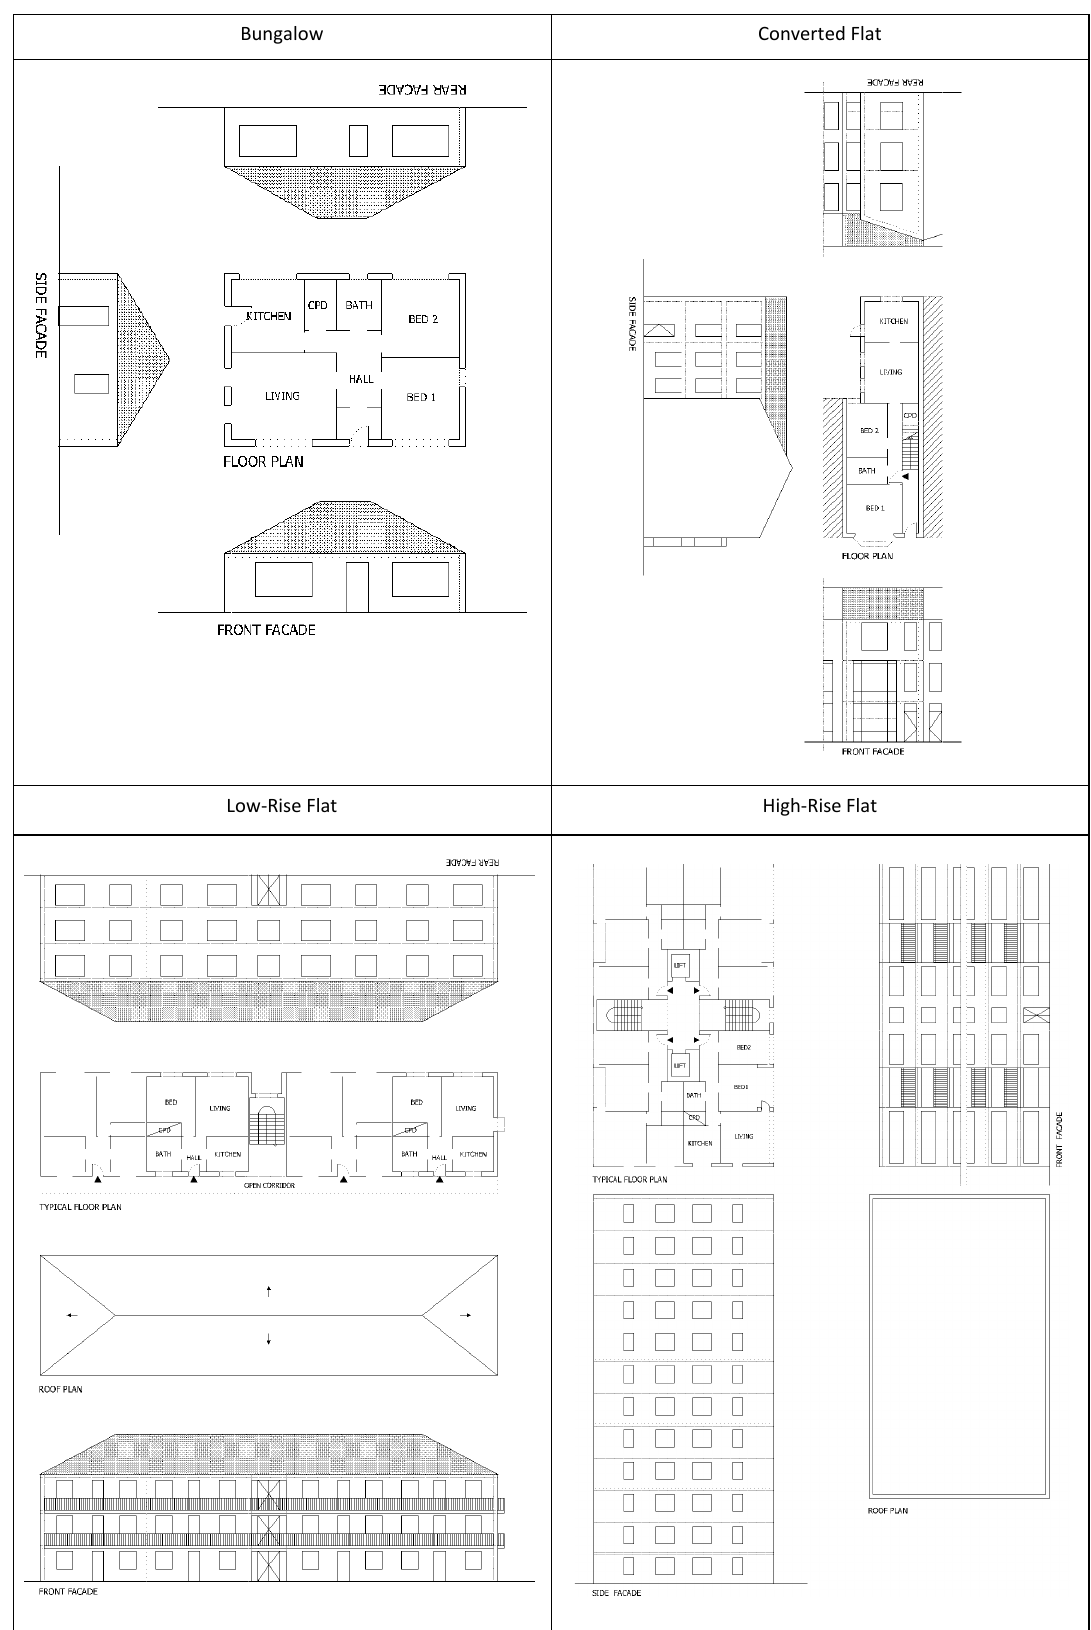
Figure A1. Building